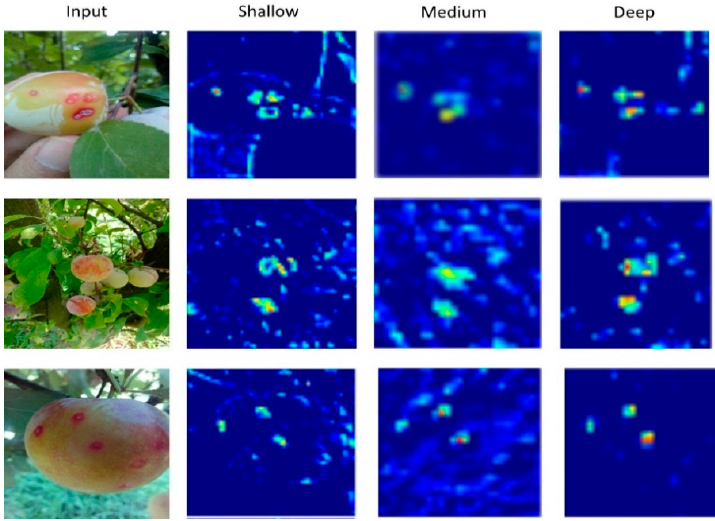
Figure 8. Activation response of various convolutional layers to lesions.